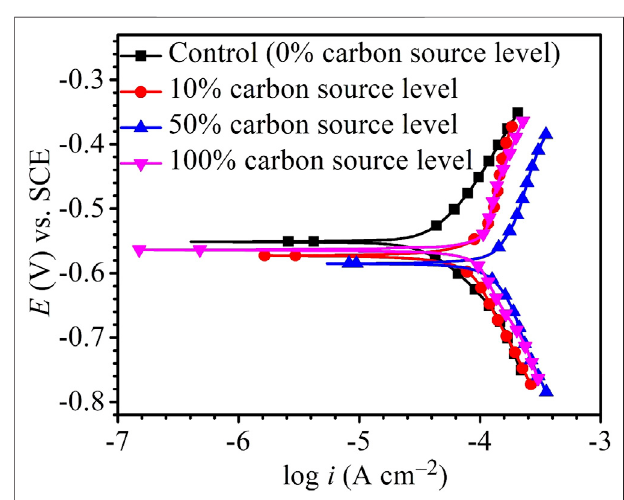
FIGURE 9 | Potentiodynamic polarization curves at the end of 14-days starvation